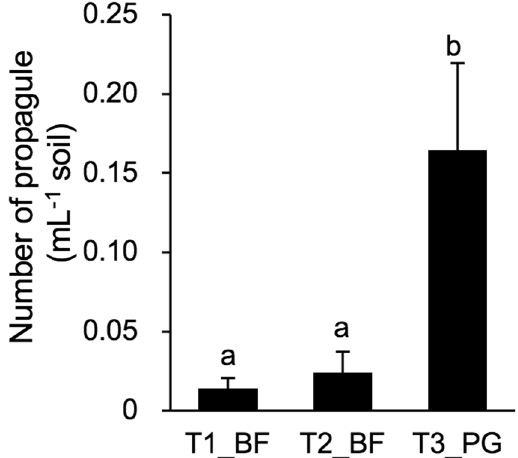
Figure 2. Most probable numbers (MPNs) of AM fungal propagule in the three trial sites. Soil samples were collected from four replicated plots in each trial site prior to fertilizer application and mixed with autoclaved sand to obtain a dilution series of 2 − 1 , 2 − 3 , 2 − 5 , and 2 − 7 , and Lotus japonicus was grown in the soil mixtures in a growth chamber for 26 days. MPNs were estimated based on the presence/absence of fungal colonization recorded under a dissecting microscope. The vertical bars indicate standard errors ( n = 4). The different letters indicate significant differences among the three trial sites (Tukey HSD test, p < 0.05).